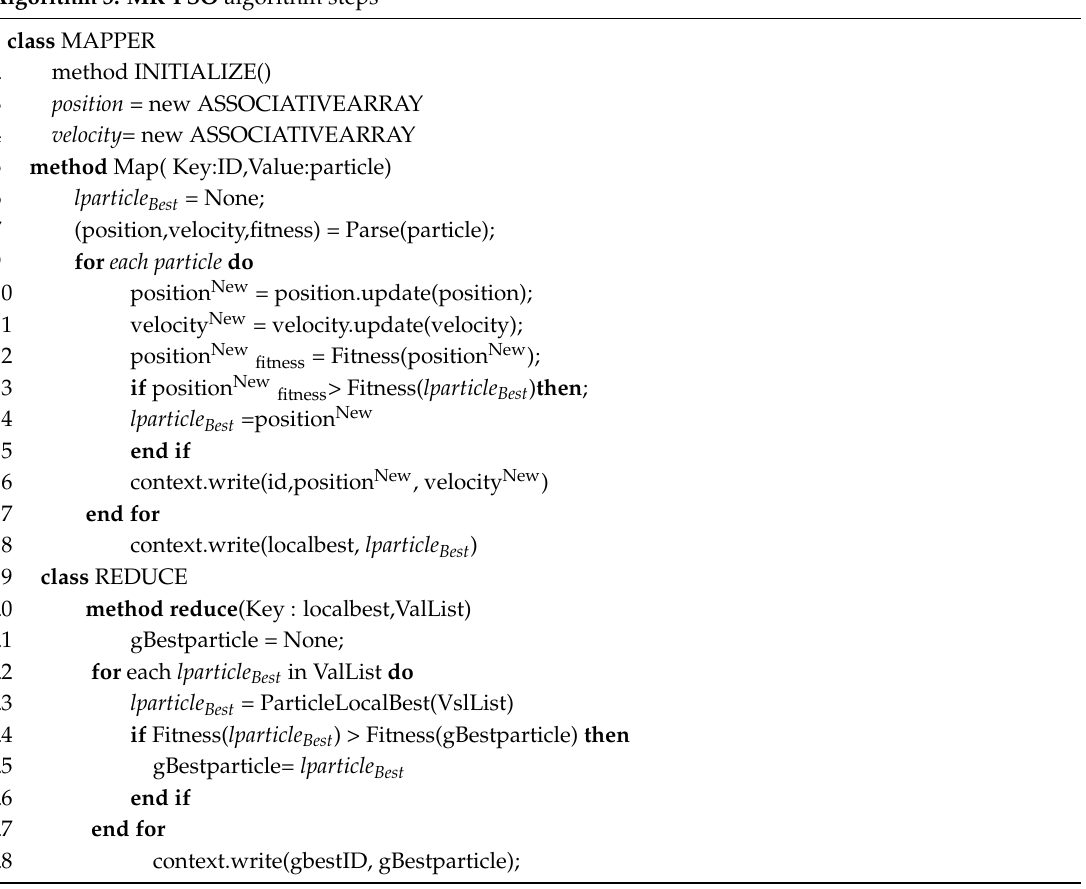
Algorithm 3: MR-PSO algorithm